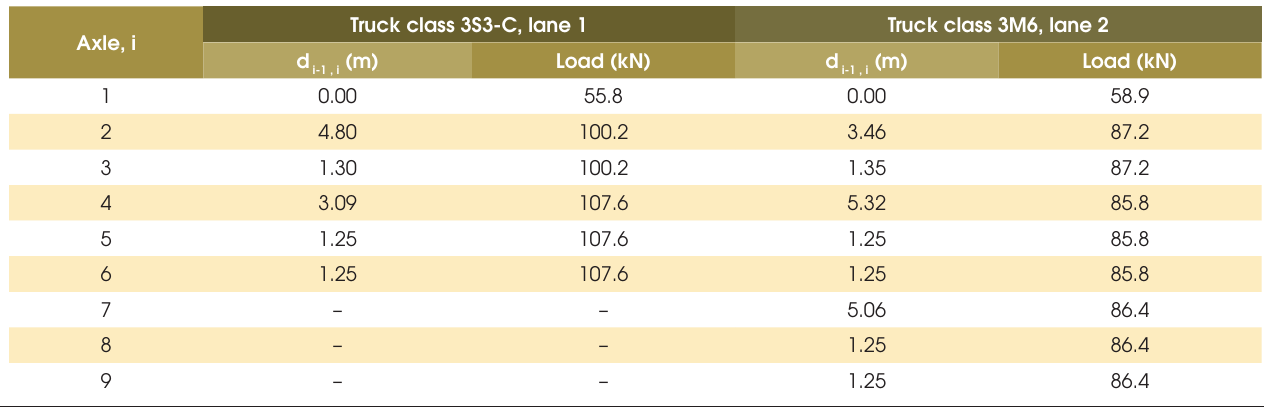
, (m) and load of the vehicles that yielded the maximum bending moment i-1 i